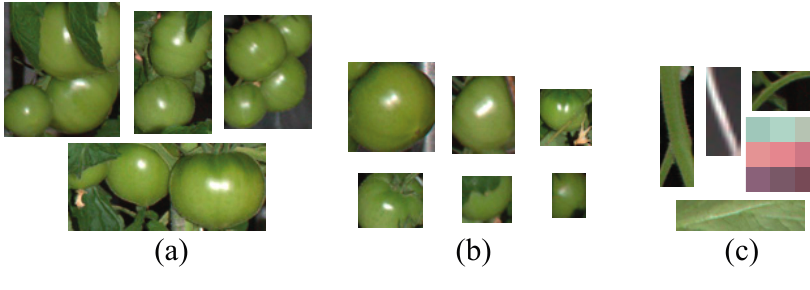
Figure 2. Examples of the training dataset for blob-based segmentation. ( a ) Multi-fruit blobs; ( b ) Single-fruit blobs; ( c ) Non-fruit blobs.